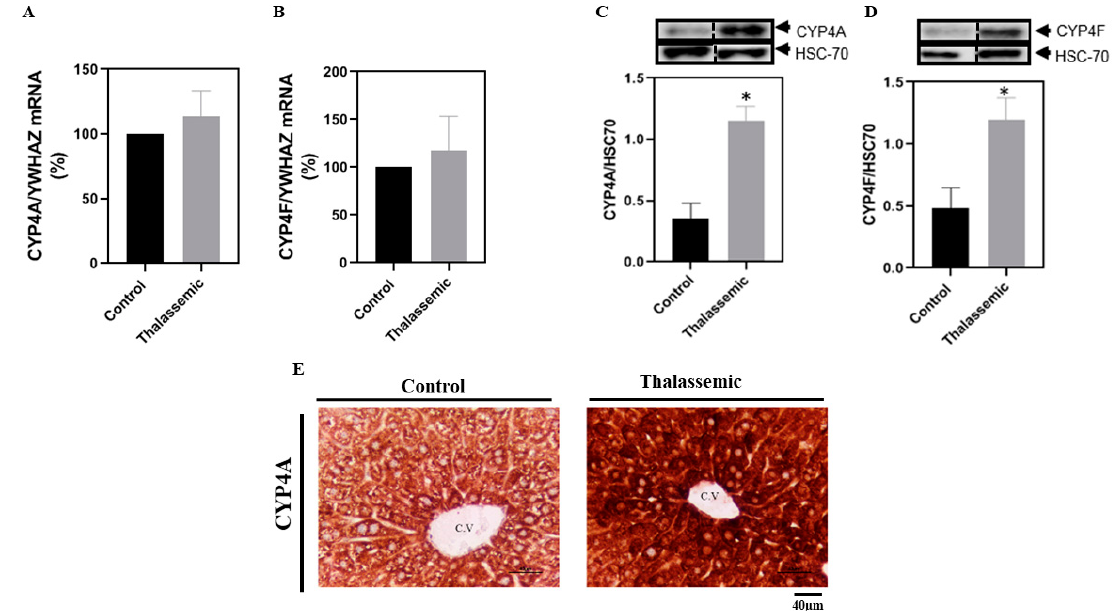
Figure 4. Overexpression of CYP4A and CYP4F in Hbb th3/+ mice. Relative mRNA levels (%) of ( A ) CYP1A/YWHAZ and ( B ) CYP4A/YWHAZ. Representative Western blot of ( C ) CYP4A/HSC70 and ( D ) CYP4F/HSC70, with the respective densitometric quantification in liver tissues of control and Hbb th3/+ mice. ( E ) Immunohistochemistry staining of liver tissue sections at 20× for CYP4A expression in control mouse, and CYP4A expression in Hbb th3/+ mice. Scale bar represents 40 μ m. Values are the means ± SEM from 4 different mice in each group ( n = 4). * p < 0.05 versus control. C.V: central vein.